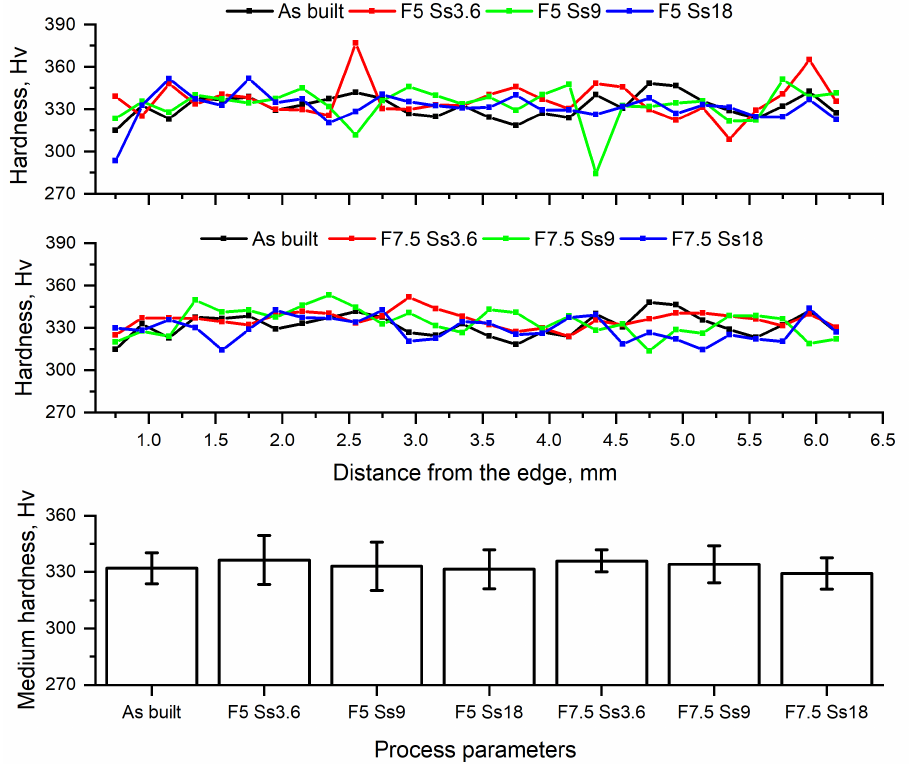
Figure 14. Microhardness along the cross